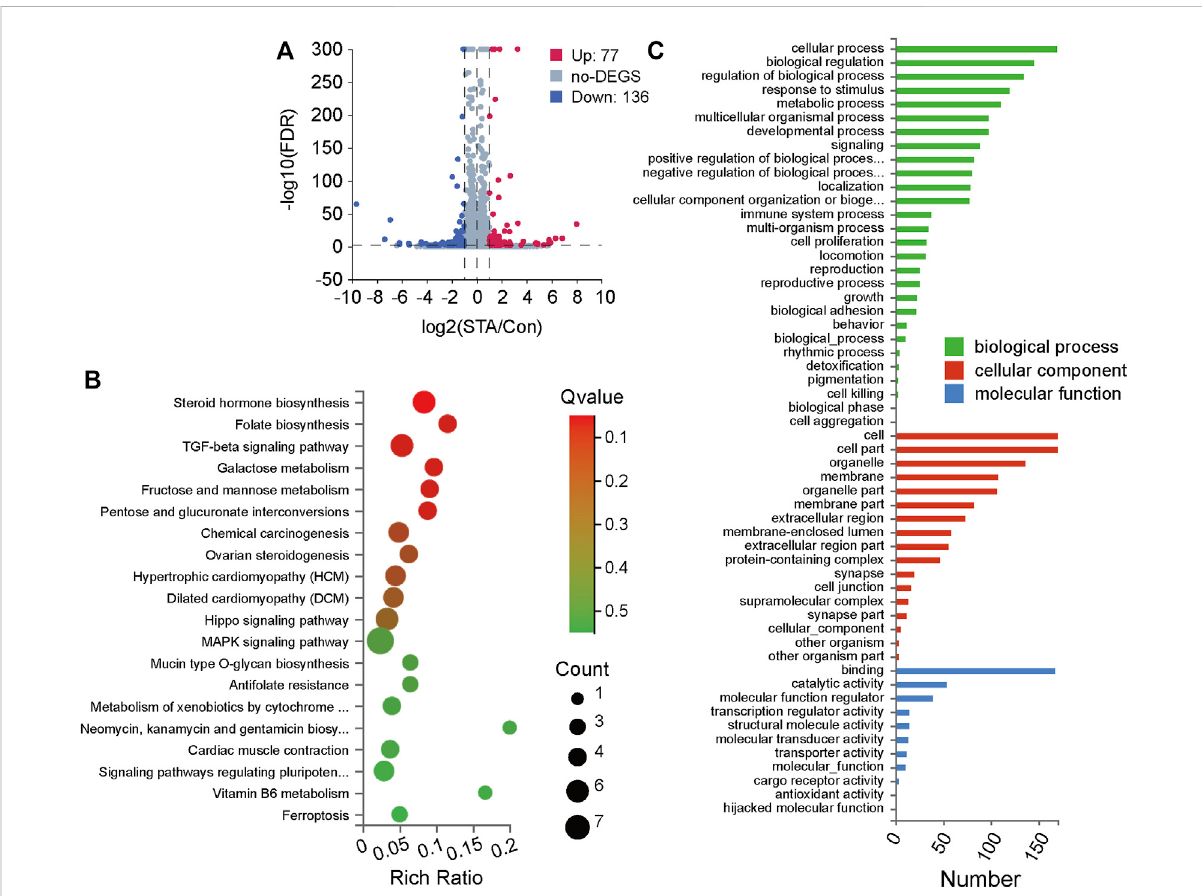
FIGURE 4 STA regulates the differentially expressed genes and pathway enrichment analysis in Hep3B cells. (A) Signi fi cant differentially expressed genes were shown in volcano plot. FC (fold change) > 1 was accepted as positive differentially expressed genes, up for 77; down for 136. (B) KEGG pathway enrichment analysis, a larger p -value ( − Log10) shows a higher degree of enrichment. (C) GO annotations analysis of Hep3B cells treated with STA, compared with control